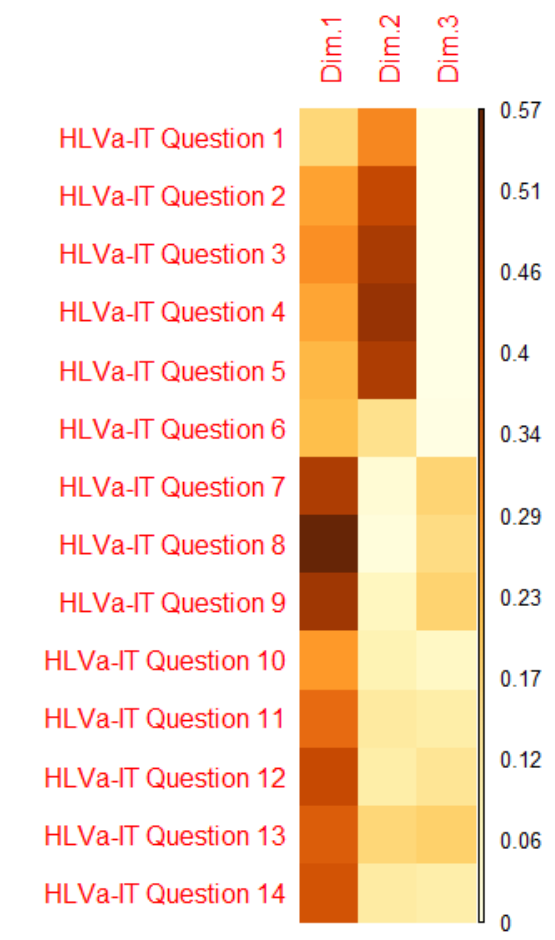
Cronbach’s alpha ranging from 0.85 to 0.89 and the Omega total coefficient from 0.90 to 0.92 (Table 3). Table 3. Internal consistency: standardized Cronbach’s alpha and Omega total coefficient.